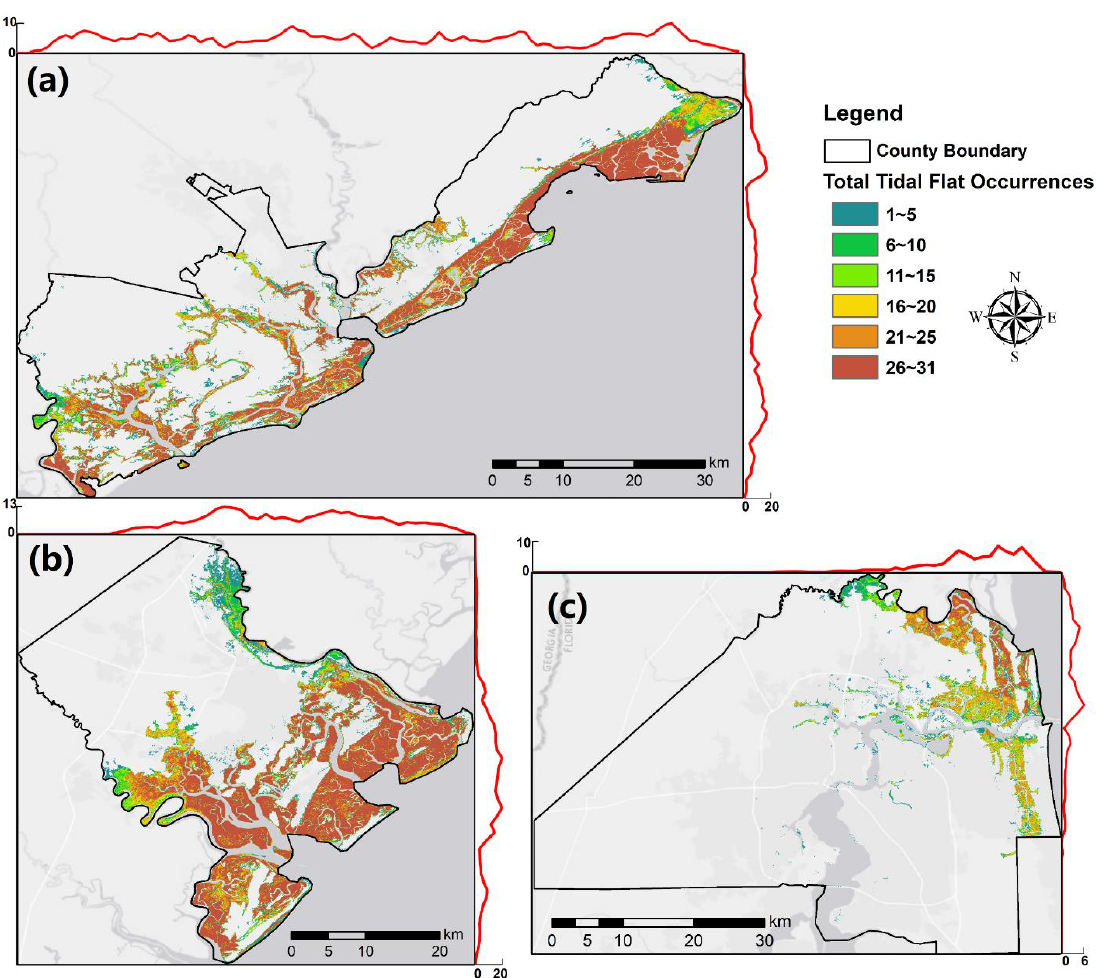
Figure 5. The spatial distribution of total tidal flat occurrences (in year) in ( a ) Charleston, SC; ( b ) Chatham, GA; and ( c ) Duval, FL. The annual average areas (in km 2 ) summarized by latitudes and longitudes are visualized as line charts along map edges. (The World Light Gray Basemap is used as the background, which is provided by Esri, HERE, Garmin, © OpenStreetMap contributors, and the GIS User Community.)